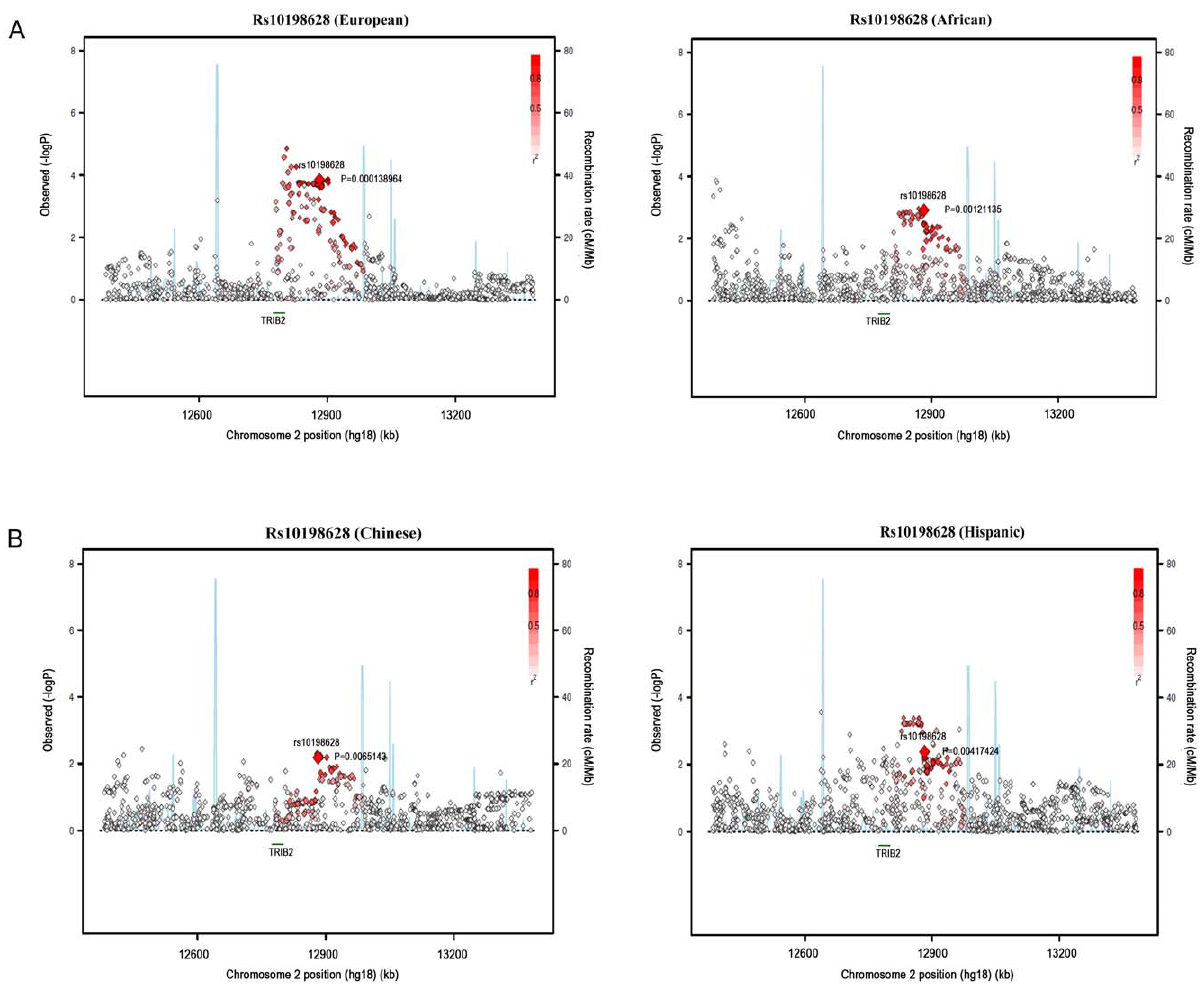
Figure 1. Regional association plots of rs10198628 in MESA ancestry populations. European, African (A), Chinese, and Hispanic ancestry population (B).